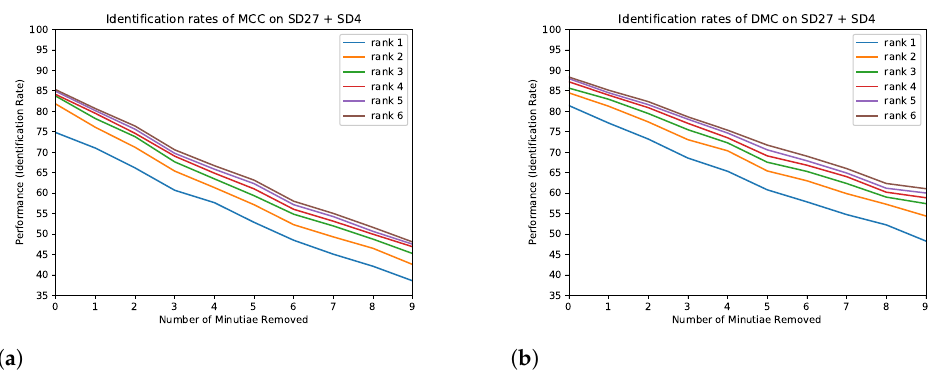
Figure 6. Curves showing the identification rates of both MCC and DMC matching algorithms when a random number of minutiae are removed. ( a ) Curves showing the MCC matching algorithm’s identification rates when a random number of minutiae is removed. ( b ) Curves showing the DMC matching algorithm’s identification rates when a random number of minutiae is